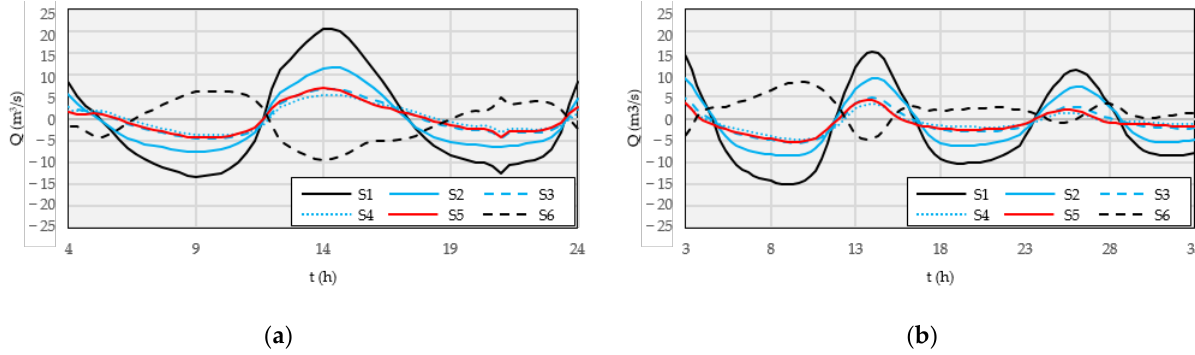
Figure 9. Water flow through selected cross sections indicated in Figure 5: ( a ) Hydrographs resulting from the Bora sim-